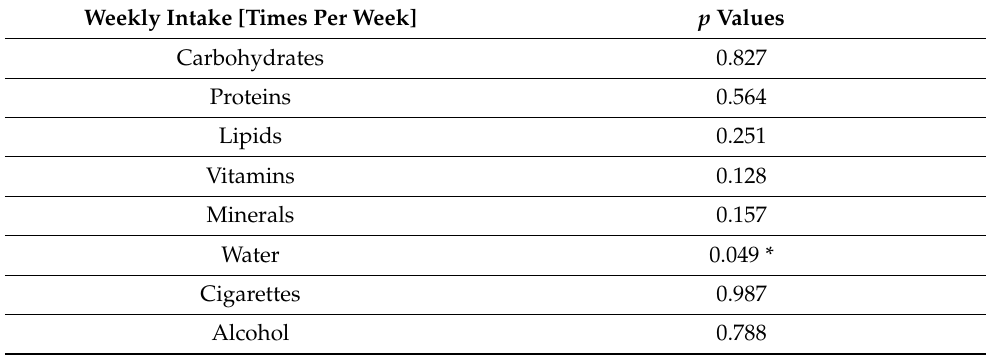
Table 5. Change in dietary habits in relation to frequency of consumption per week in the study population. Results were obtained using the Chi-square test. Single asterisks represent the statistically significant difference (* p < 0.05) in distribution of responses among study